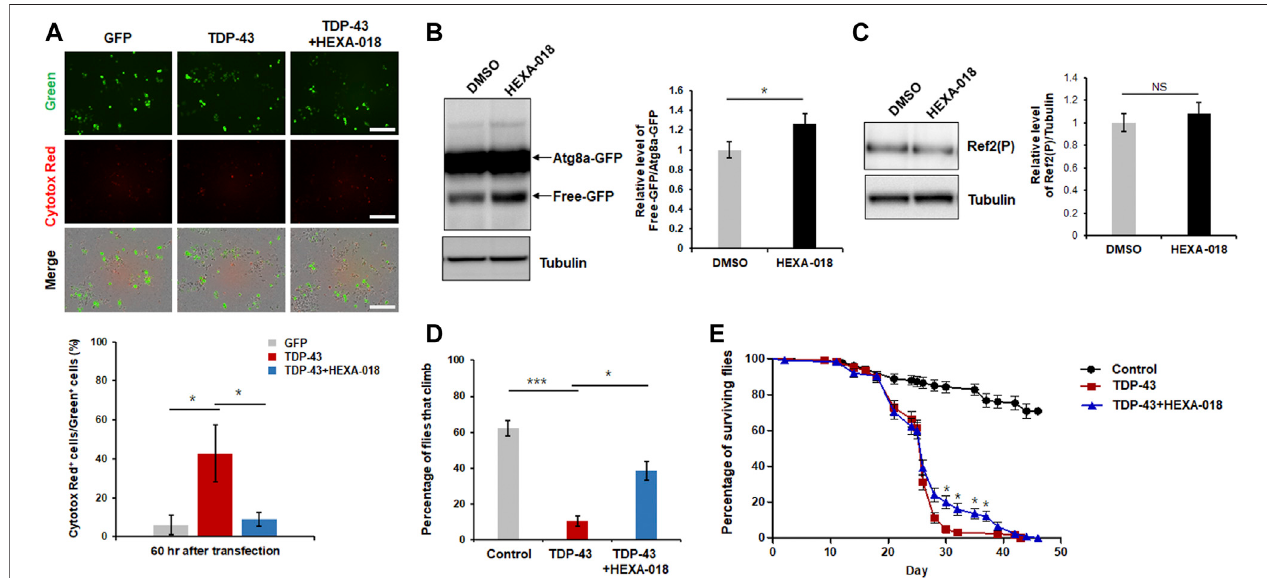
FIGURE 6 | HEXA-018 suppresses TDP-43-induced toxicity in neuronal cells and Drosophila . (A) N2a cells were transfected with the GFP or TDP-43-GFP expressionconstructfor6 handsubsequentlytreatedwithHEXA-018(5 µM)for54 h.Dyingneuronalcells,asindicatedbyred fl uorescence,wereimagedevery3 hand quanti fi ed by counting double- fl uorescent (green and red) cells using the IncuCyte system. HEXA-018 signi fi cantly reduced TDP-43-induced neuronal toxicity. Data are presentedasthemean ± SDof3independent experiments. * p < 0.05(one-way ANOVAwithTukey ’ smultiple comparison test).Scale bar,200 μ m. (B) HEXA-018 treatment increased ALP activation. Western blot analysis of Atg8a-GFP and free GFP protein levels in the head lysates of fl ies. Quanti fi cation of immunoblots was performed from 3 independent experiments, and protein levels were normalized to that of tubulin. Data are presented as the mean ± SD. Genotypes: elavGS, UAS- Atg8a-GFP/+ . * p < 0.05 (unpaired Student ’ s t -test). (C) Western blot analysis of Ref2(P) protein levels in the head lysates of Atg8a-GFP fl ies. Quanti fi cation of immunoblots was performed from 3 independent experiments, and protein levels were normalized to that of tubulin. HEXA-018 treatment did not affect Ref2(P) protein level.Dataarepresentedasthemean ± SD.Genotypes: elavGS,UAS-Atg8a-GFP/+ . n.s. ,notsigni fi cant(unpairedStudent ’ s t -test). (D,E) Climbingabilityandlifespanof TDP-43 fl ies fed HEXA-018 (10 μ M) at the indicated time points. The TDP43-induced motility de fi cit was signi fi cantly reduced by treatment with HEXA-018. The percentages of fl ies that climbed or survived were quanti fi ed. Genotypes: control is elavGS/+ , TDP-43 is e lavGS, UAS-TARDBP/+. Data are presented as the mean ± SEM ( n (cid:2) 4 replicates per condition, each with n (cid:2) 25 fl ies per sample). * p < 0.05; *** p < 0.001 (one-way ANOVA with Tukey ’ s multiple comparison